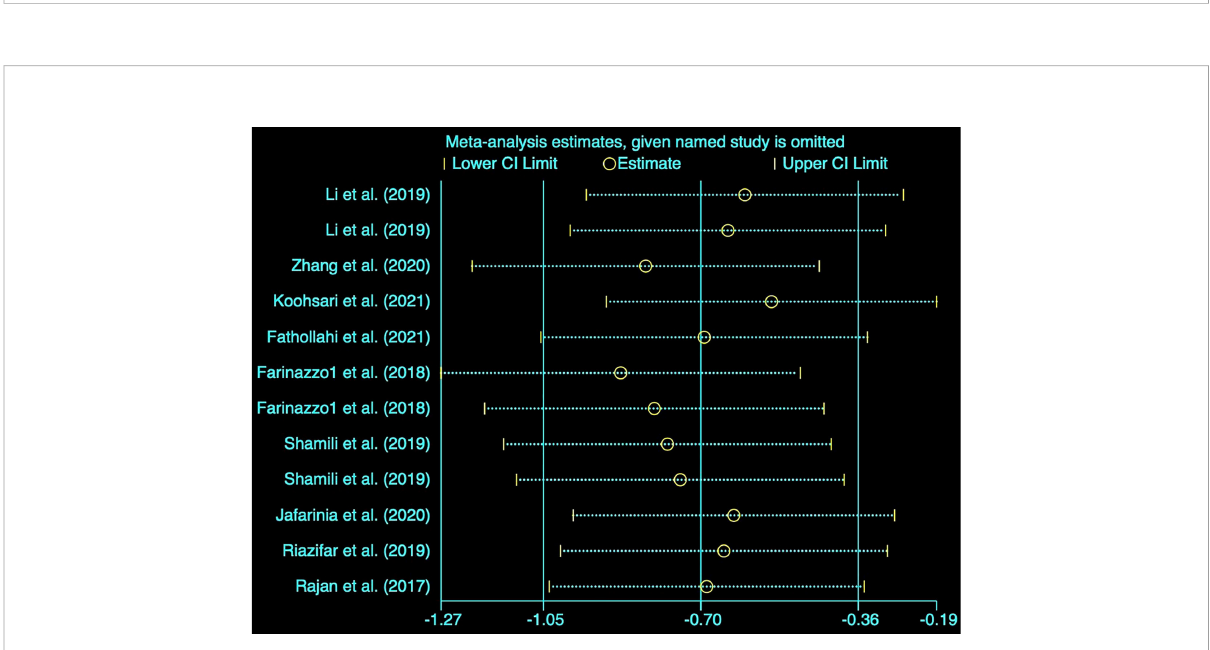
FIGURE 3 Sensitivity analysis of the studies included in clinical